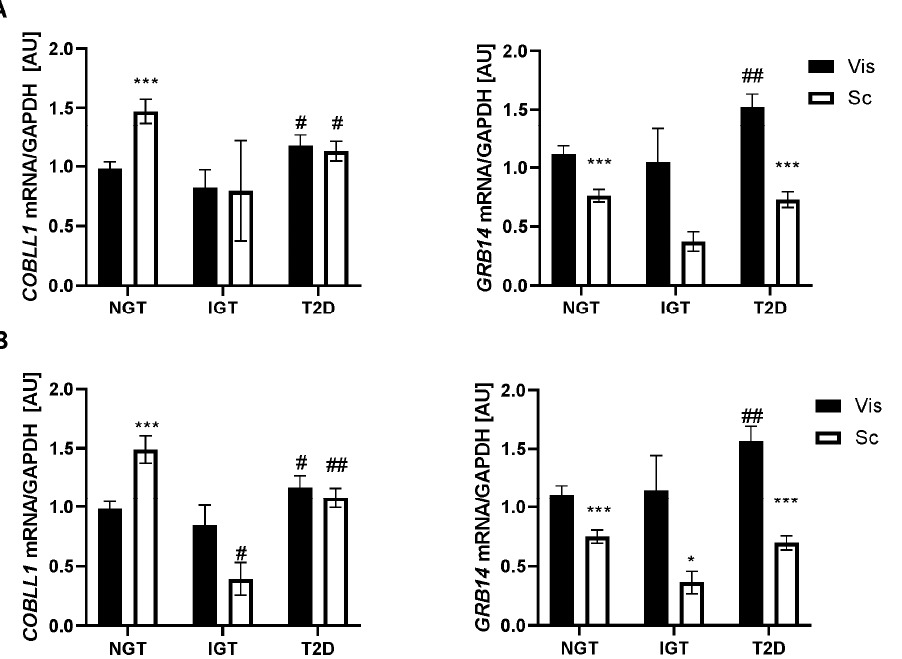
Figure 3. ( A ) COBLL1 and GRB14 mRNA expression in paired human visceral (vis) and subcutaneous (sc) adipose tissue (AT) samples grouped by type 2 diabetes status (NGT: subjects with normal glucose tolerance, n = 238; IGT: subjects with impaired glucose tolerance, n = 10; subjects with Type 2 diabetes, n = 197). Mean ± SEM; *vis vs. sc AT depot; #IGT/T2D vs. NGT; # p < 0.05; ## p < 0.01; *** p < 0.001. ( B ) COBLL1 and GRB14 mRNA in paired human visceral (vis) and subcutaneous (sc) adipose tissue (AT) samples grouped by type 2 diabetes status in BMI ≥ 40 kg/m 2 patients. (NGT: subjects with normal glucose tolerance, n = 200; IGT: subjects with impaired glucose tolerance, n = 9; T2D: subjects with diabetes, n = 175). Mean ± SEM; *vis vs. sc AT depot; #IGT/T2D vs. NGT; */# p < 0.05; ## p < 0.01; *** p < 0.001.